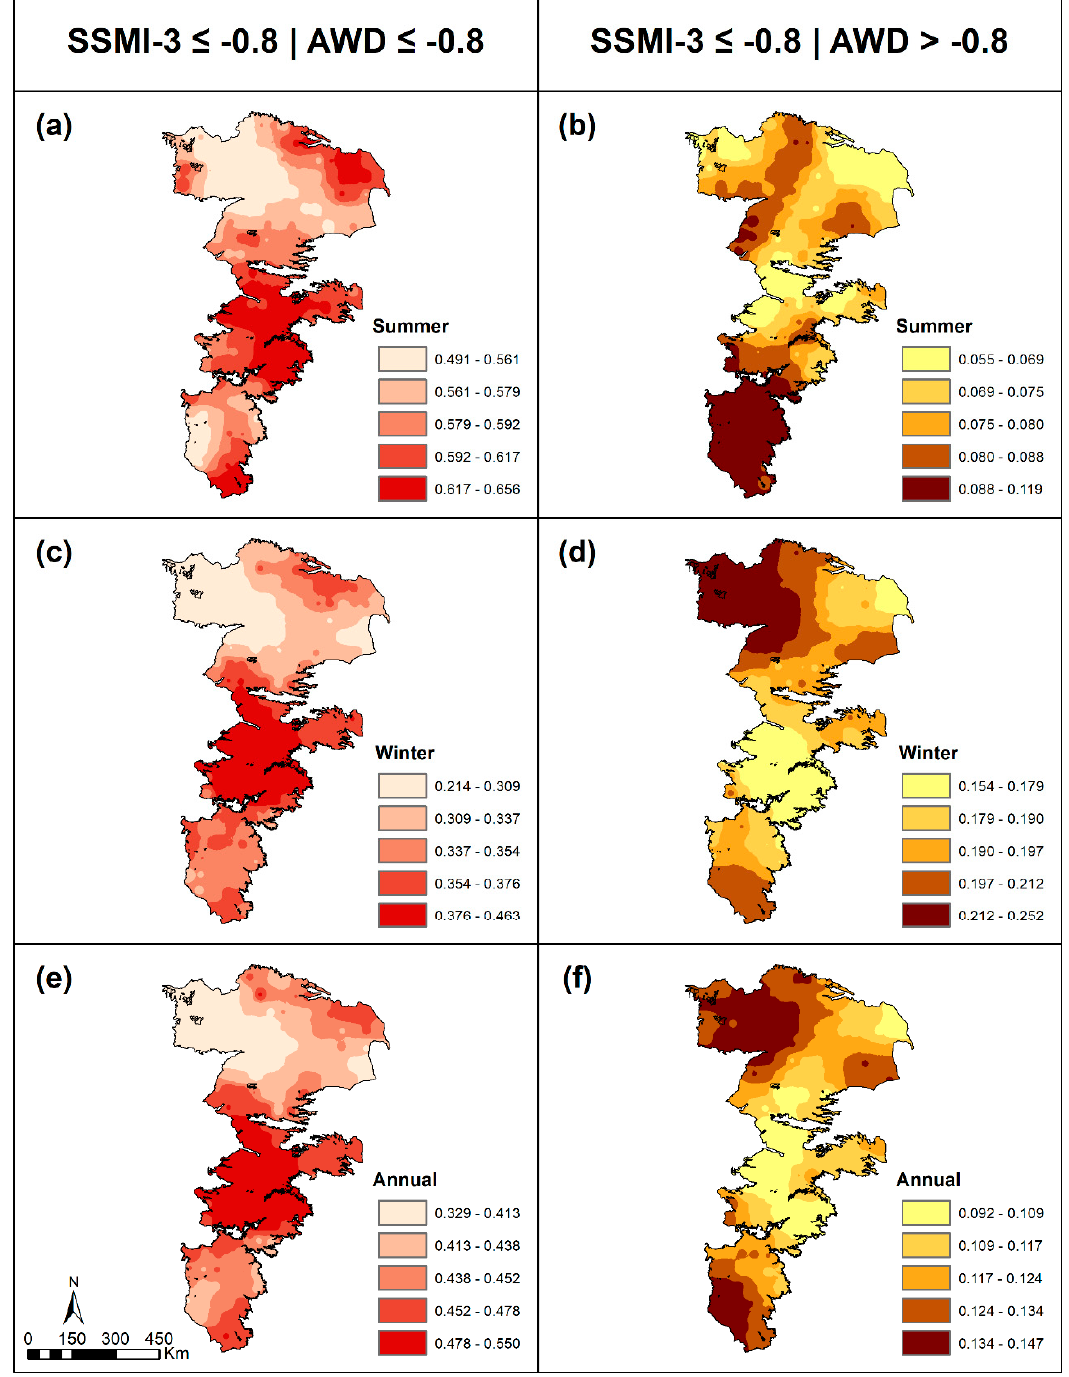
Figure 11. Agricultural drought risk based on SSMI3 given dry (AWD ≤ − 0.8) and not dry (AWD > − 0.8) atmospheric water states. (Dry states depicted in Figures ( a , c , e ) and not dry states in Figures ( b , d , f )).